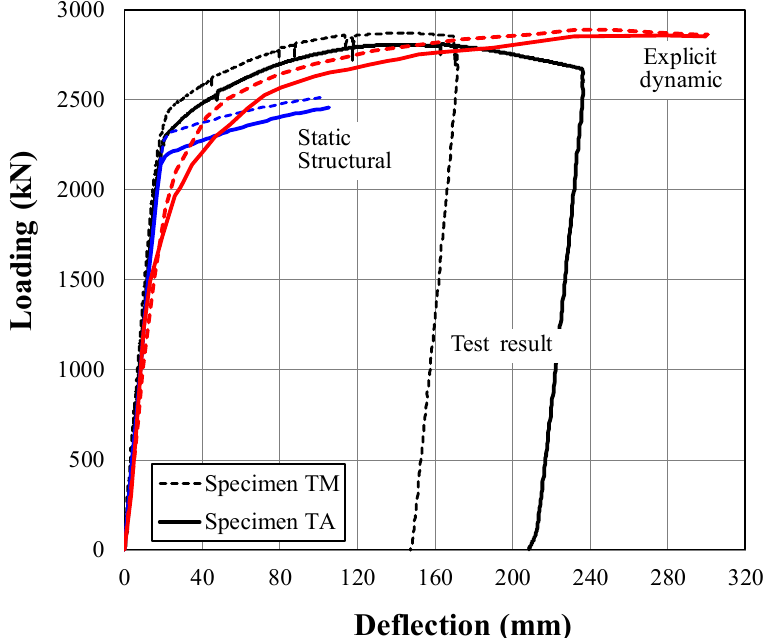
Figure 14. Flexural behavior of analysis result.